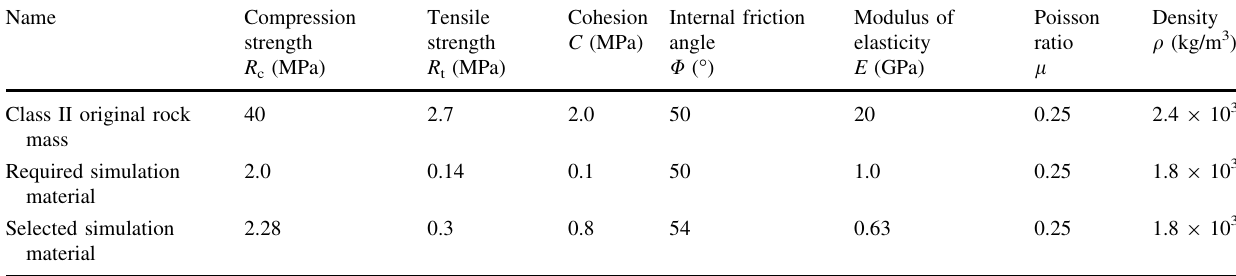
Table 1 Mechanical parameters of the original rock and the simulation materials Name